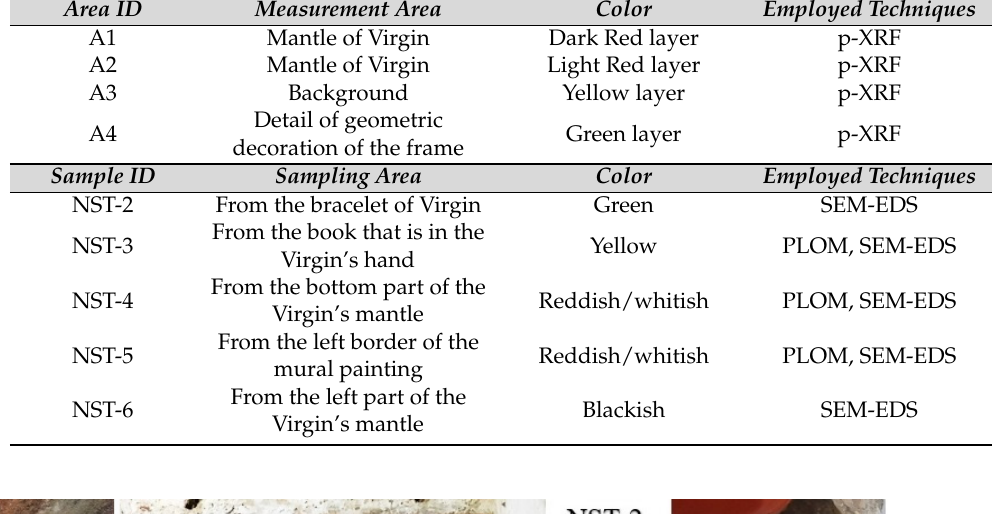
Table 1. Mural painting depicting the “Virgin”: an overview of areas investigated and sampled both with in situ and laboratory-based methods.